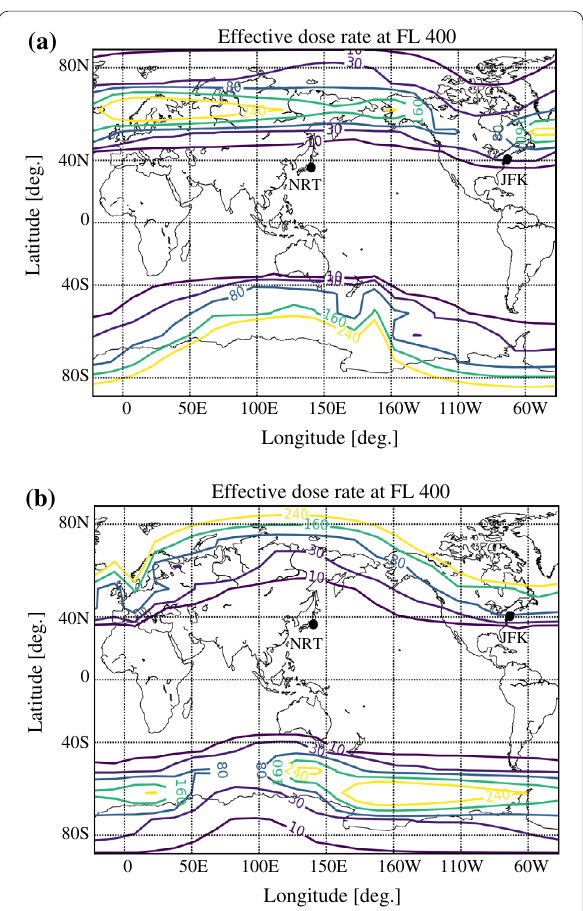
Fig. 2 a Estimated EDR in µ Svh − 1 at FL 400 (12.19 km) at 0655 UT on 20 January 2005. b Estimated EDR at an altitude of FL 400 (12.19 km) at 0655 UT on 20 January 2005, but with flipping the northern and southern